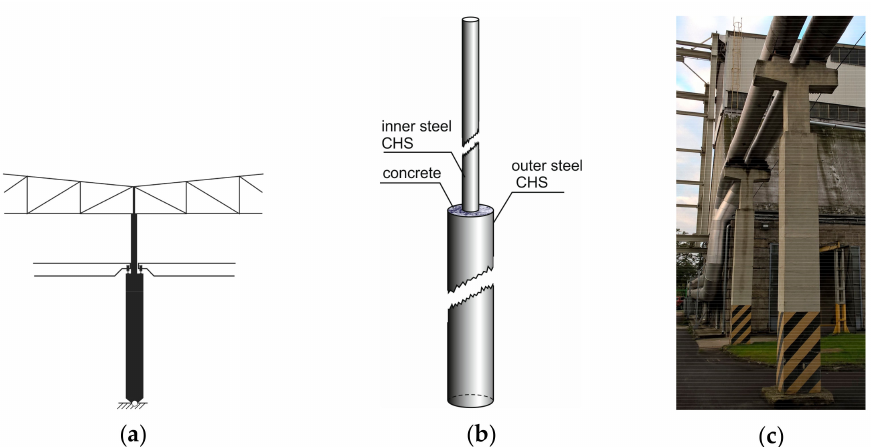
Figure 1. Examples of two-segment stepped columns: ( a ) An inner column in industrial multi-nave steel mill building; ( b ) CHS column filled by concrete in lower part; ( c ) Two stepped, industrial column.